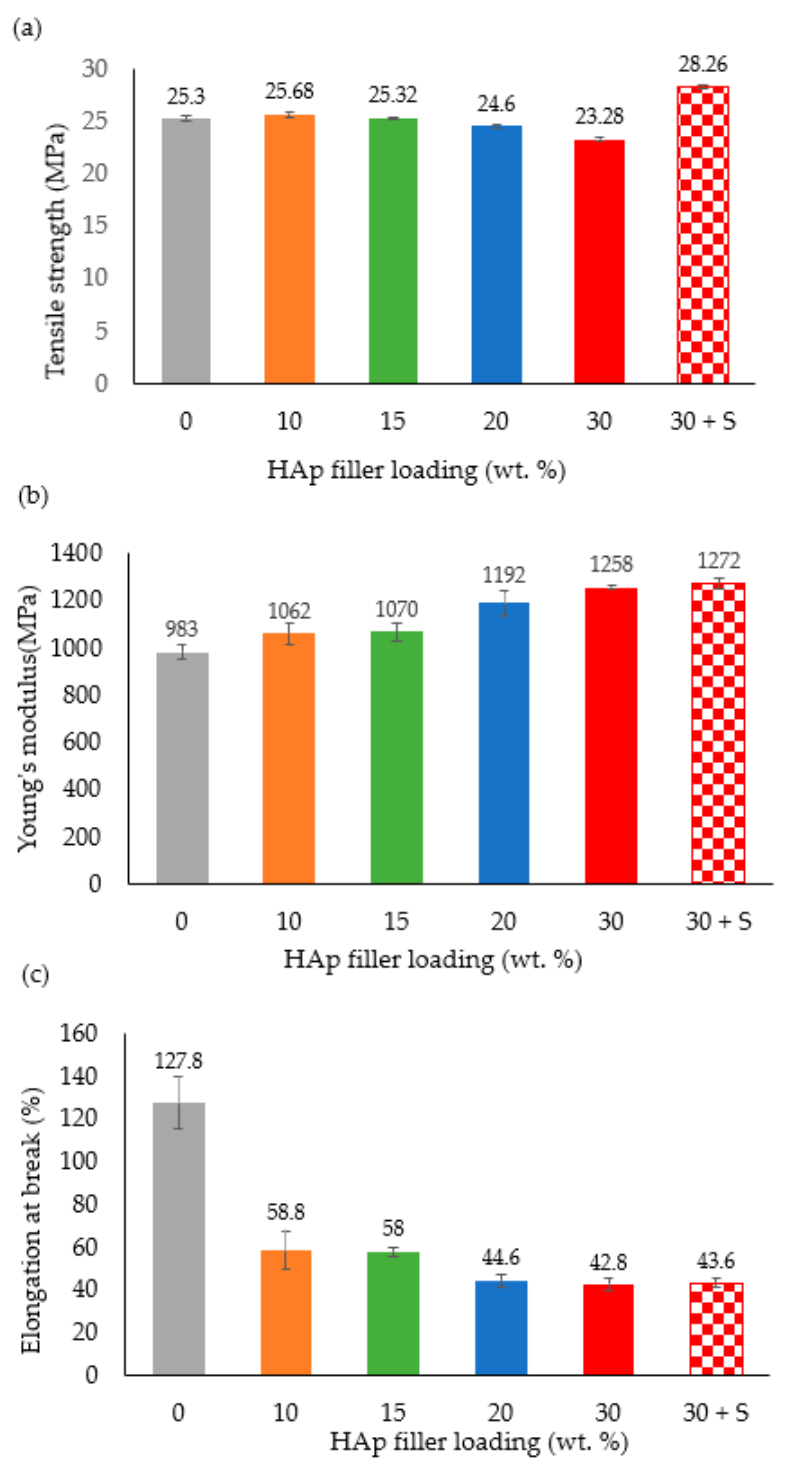
Figure 5. Effects of HAp filler on ( a ) tensile strength, ( b ) Young’s modulus, and ( c ) elongation at break of the HDPE/HAp composites .